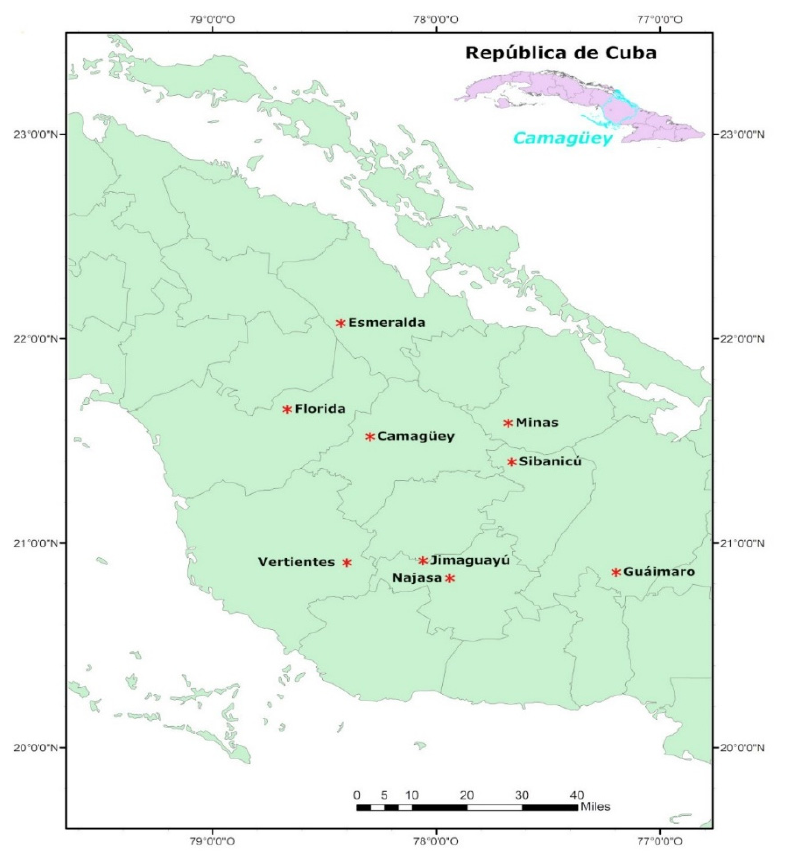
Figure 1. Map of Camagüey province with the geographic location of the centers for rearing queens. (*, Camagüey municipalities).